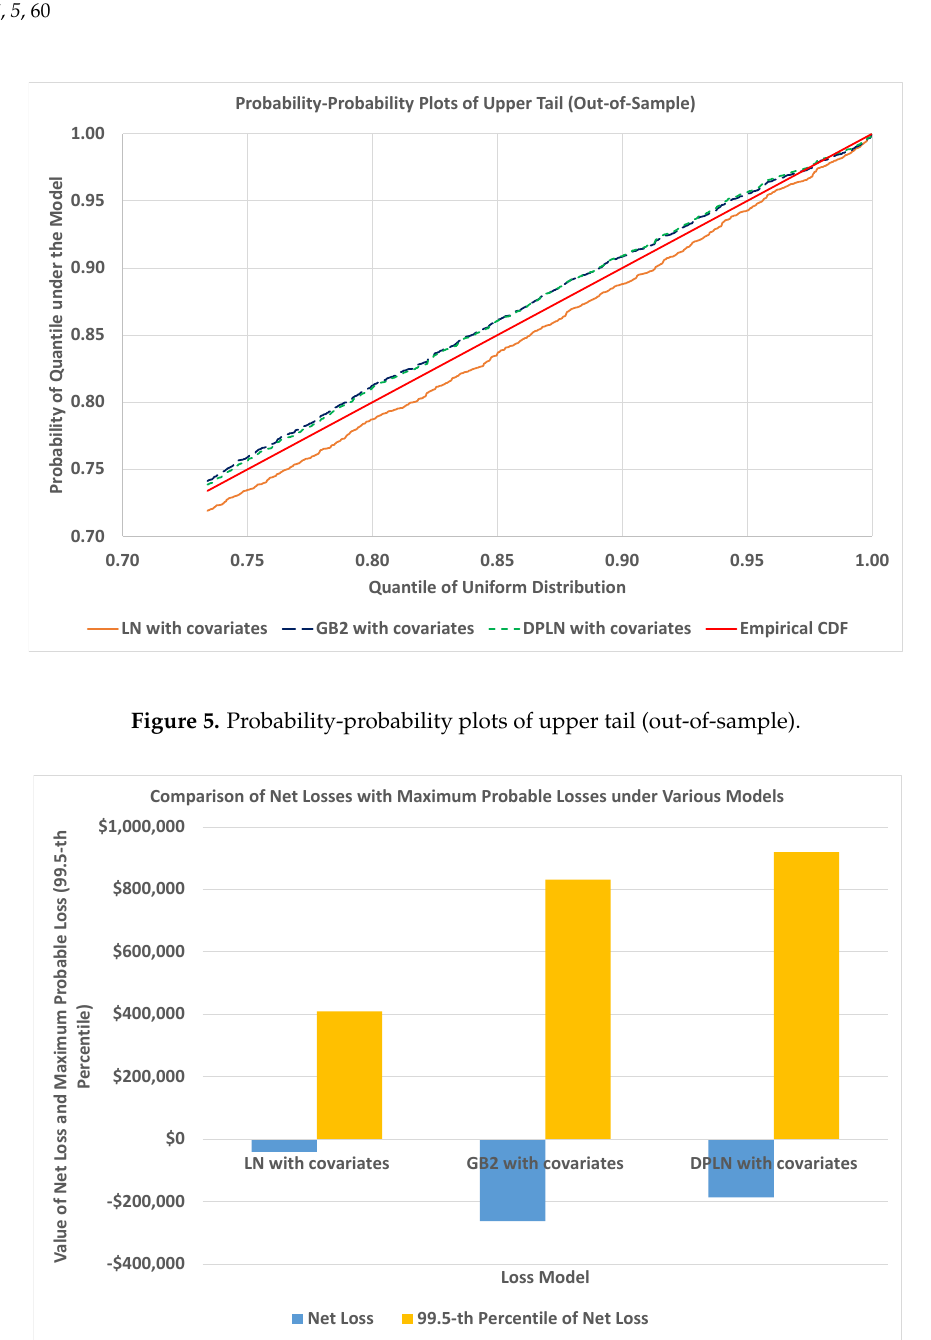
Figure 6. Net losses on a portfolio of automobile bodily injury claims for various models